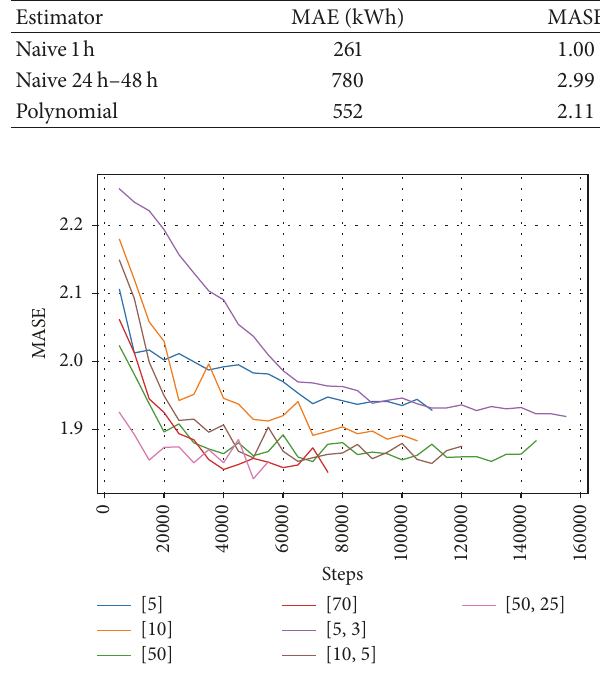
Figure 4: Trend in MASE for different FNNs with